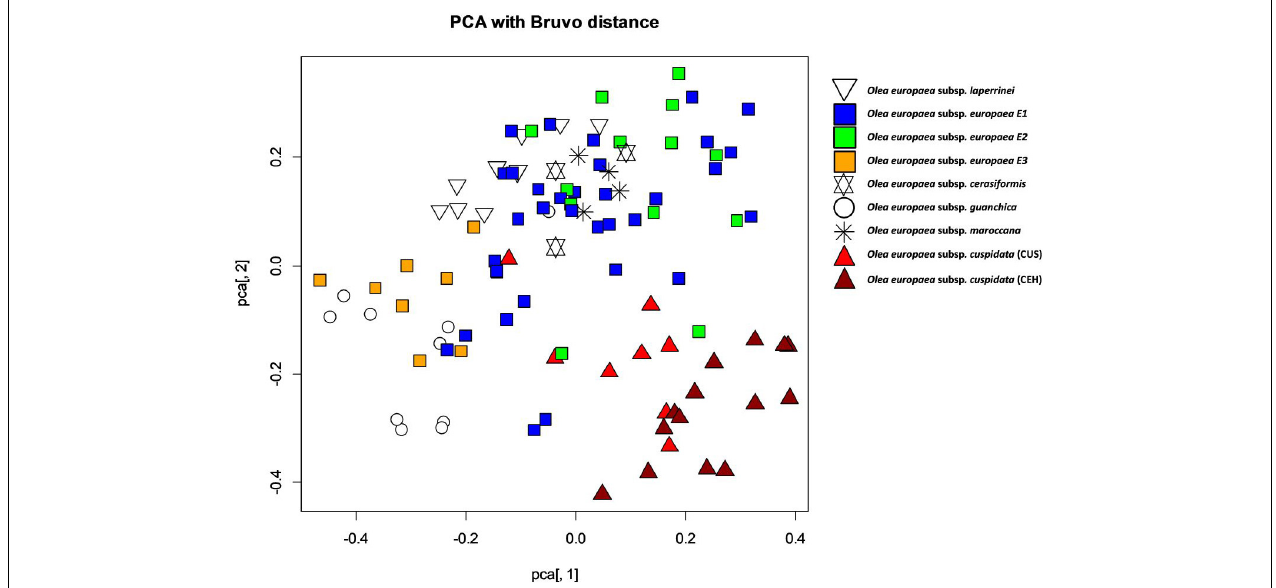
FIGURE 2 | Genetic dispersion of 105 genotypes of the SILVOLIVE collection according to nuclear SSR markers. Genetic distance matrices were calculated according to Bruvo et al. (2004). To represent the distribution of the genotypes according to their genetic distances, Principal Coordinate Analysis and plotting were subsequently performed with the package “POLYSAT” in R (Clark and Jasieniuk, 2011). Plotted symbols represent different subspecies or lineages of Olea europaea , and different colors identified the genotypes according to the classification obtained by chloroplastic markers. To compute allele copy number, POLYSAT uses the combinatorics utilities in R (the “combn” and “permn” functions from the COMBINAT package) to match all possible combinations of alleles and find the smallest sum of geometrically transformed distances between alleles (Equation 2) of Bruvo et al.